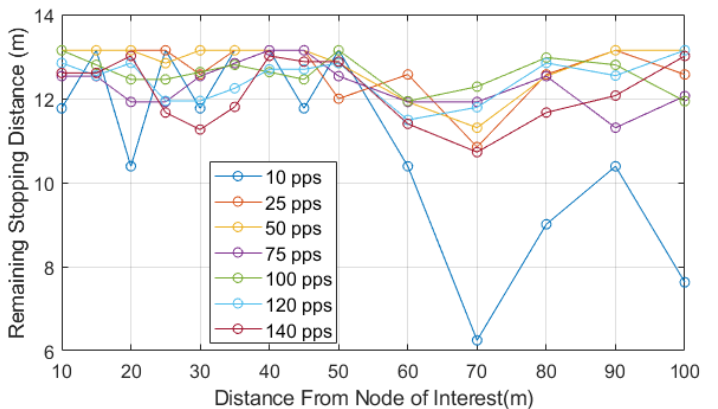
Figure 8. Packets lost over distance.